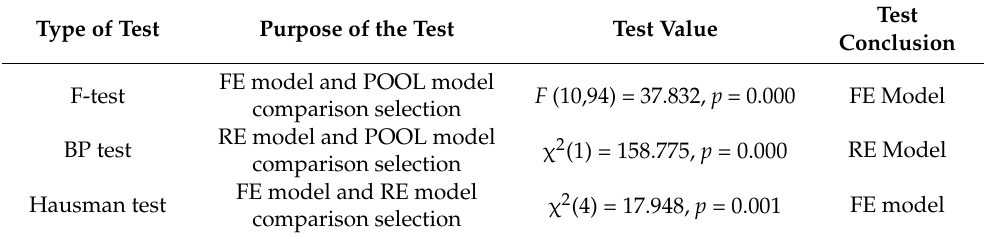
Table 8. Summary of test results (n =